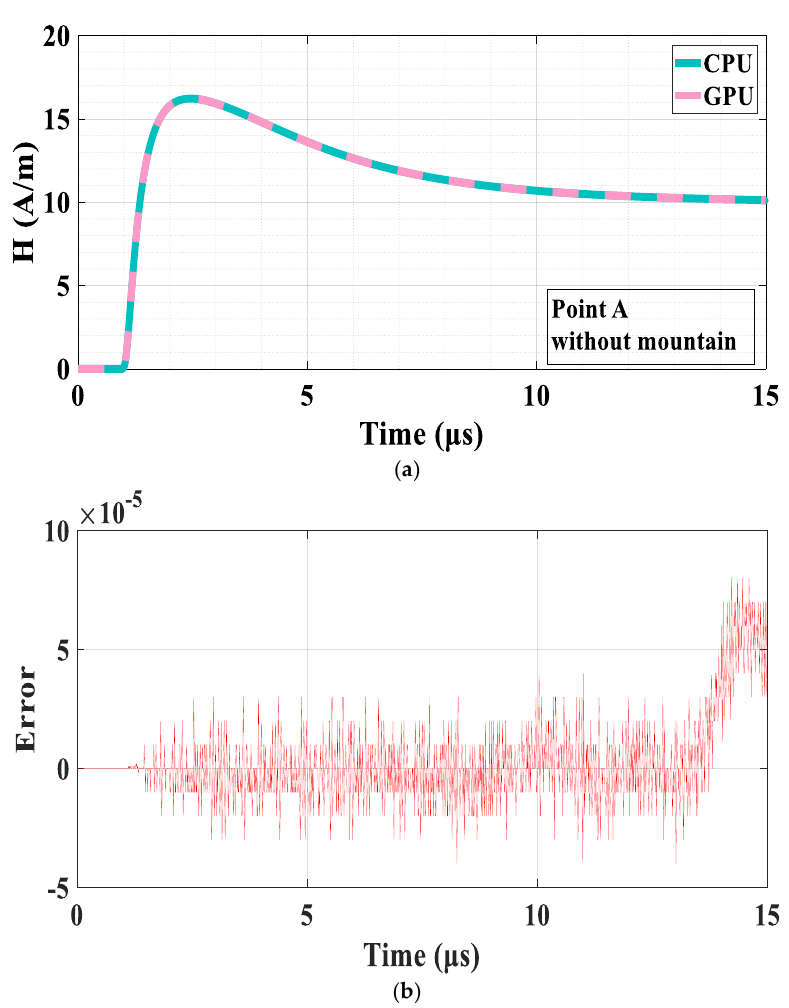
Figure 10. ( a ) The blue solid line and pink line represent the CPU and GPU processing, respectively, ( b ) Numerical error between the CPU and GPU processing.